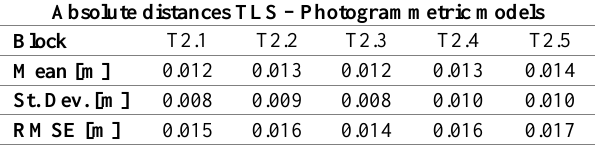
Table 6 – Absolute distances between the TLS and the photogrammetric models.